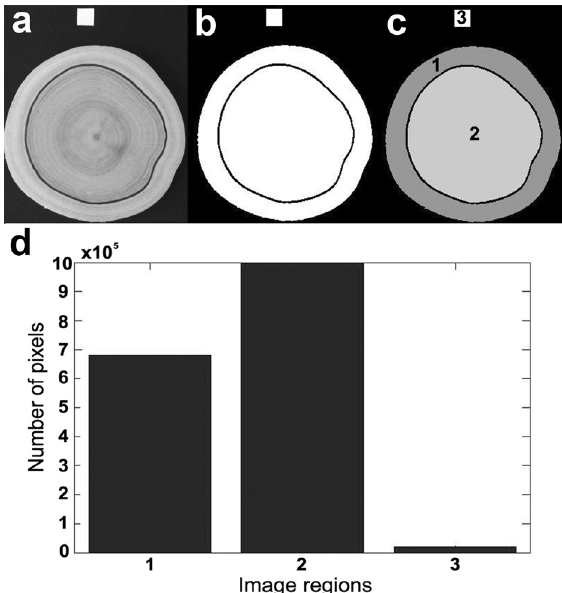
Figure 2 - Example of the stages of digital analysis of the Corymbia citriodora disk: (a) acquisition of high quality image; (b) binarization and highlight of the border of the image; (c) separation and recognition of interconnected regions; (d) Final histogram for the calculation of areas and percentages of